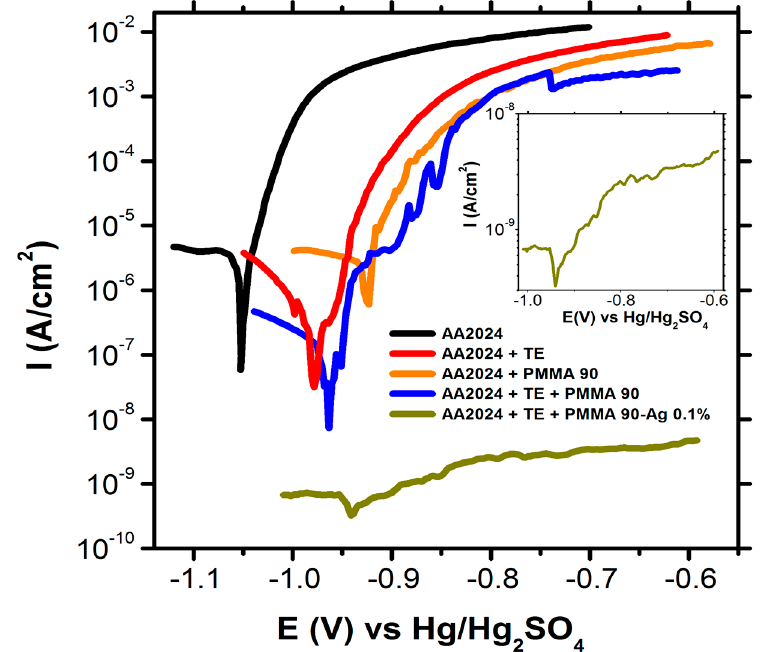
Figure 10. Anodic polarization curves of aluminum alloy surfaces differently treated and coated by polymers in 0.1 M of NaCl at a sweep rate of 0.2 mV s − 1 .